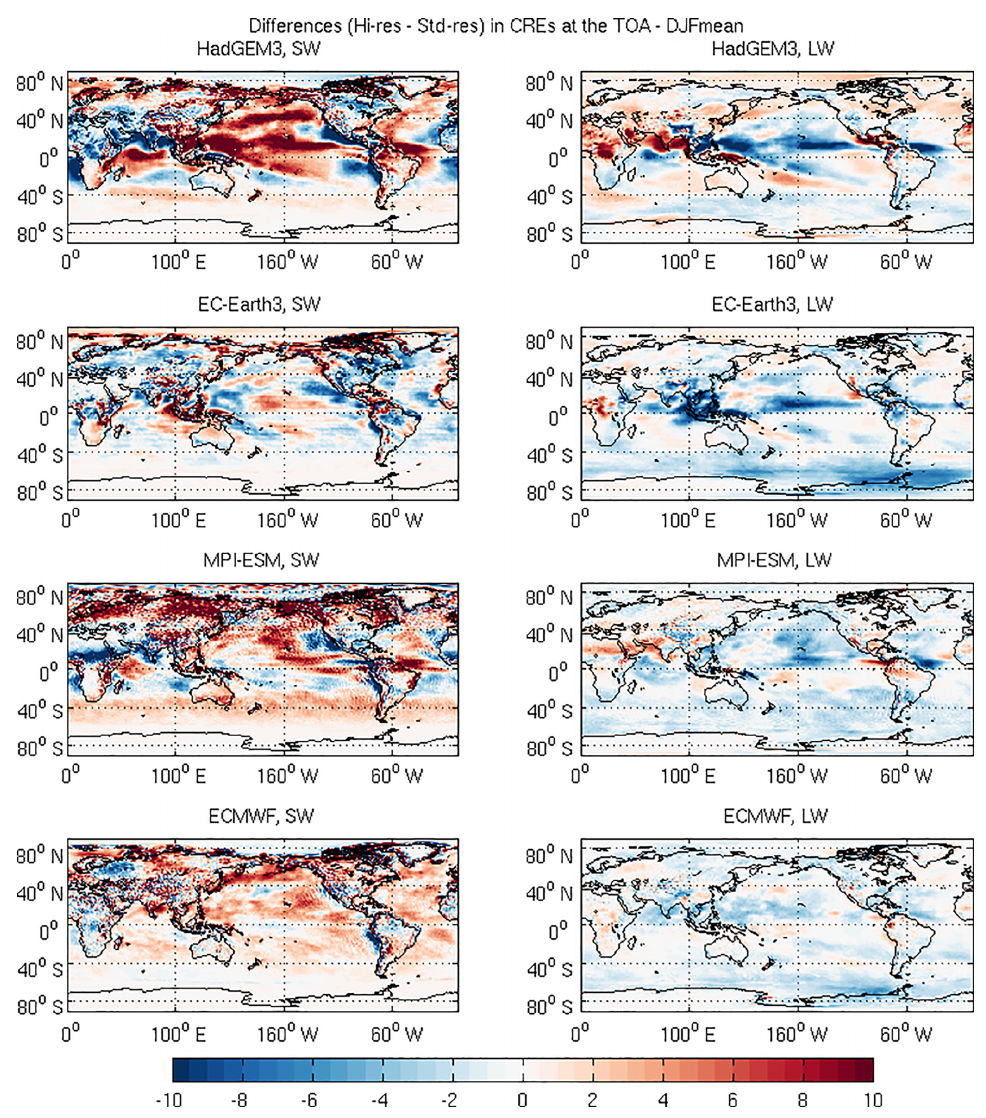
Figure 3. Same as Fig. 2 but during